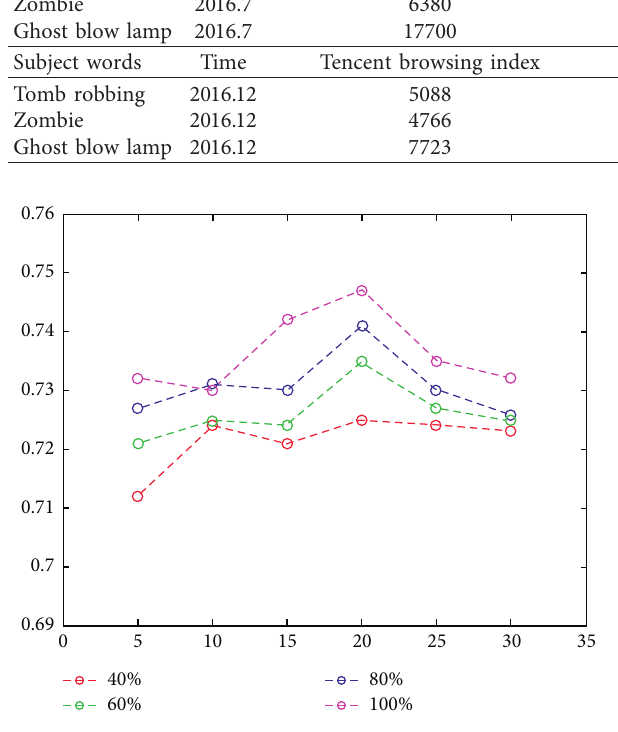
Figure 6: The influence of the number of different topics on the click through rate.